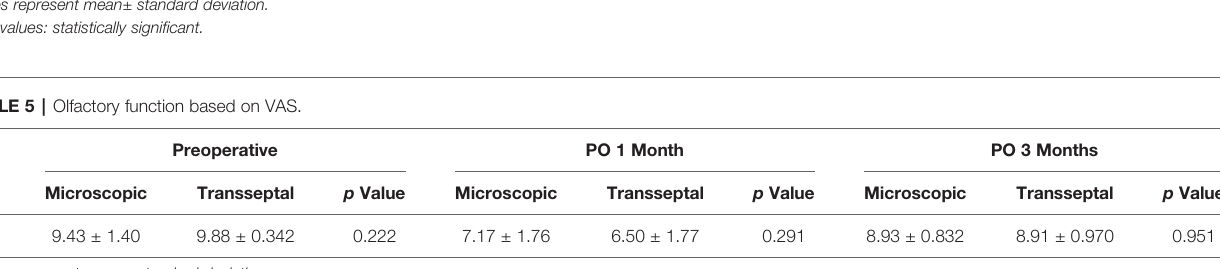
Values represent mean± standard deviation.